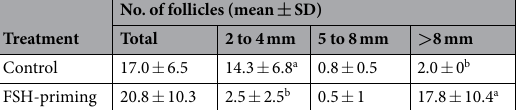
Table 1. Effect of FSH-priming on follicle size. a,b Different letters indicate significant difference at P < 0.05.